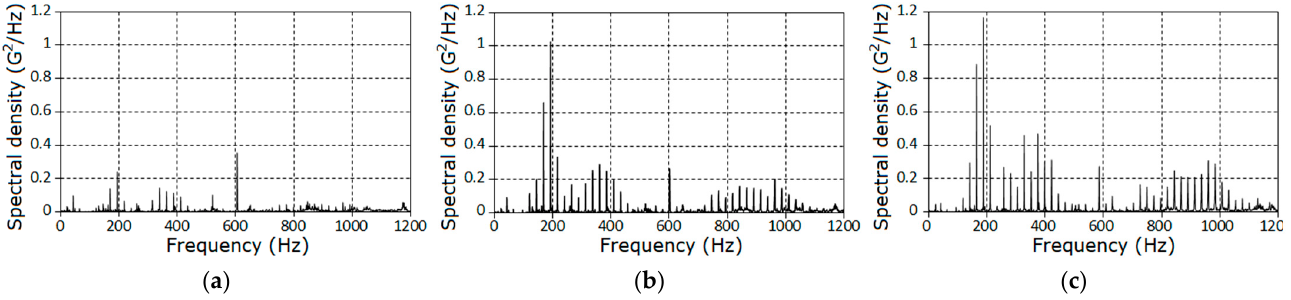
Figure 5. The power spectral density estimators for the filtered signals for each stage ( a – c ).